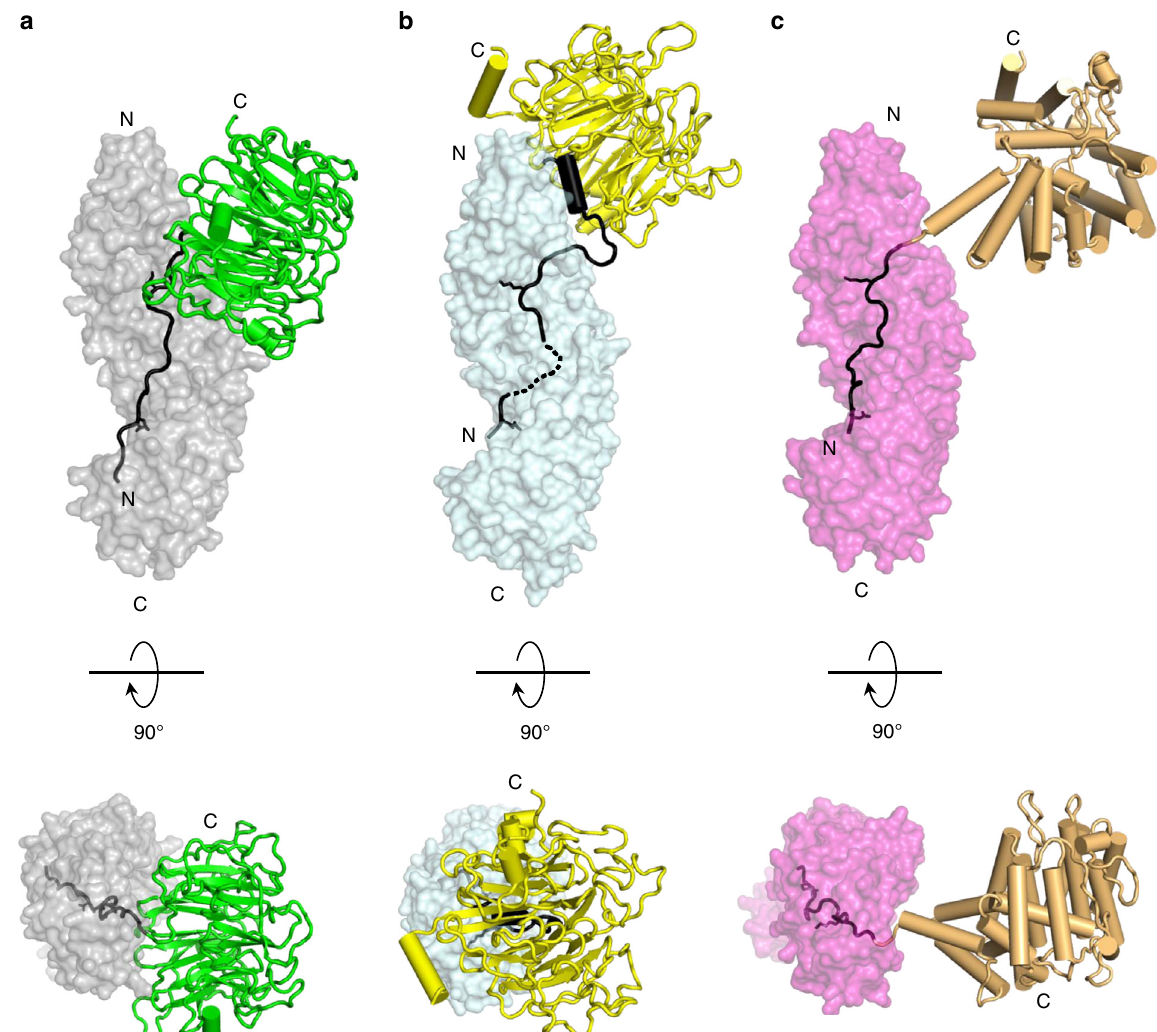
Fig. 8 Differential recognition of NLS cargos by importin α s. Recognition of a human RCC1 ( green ) by importin α 3 ( gray ), b yeast RCC1 ( yellow ) by Kap60 ( light cyan ), c CAP80 ( orange ) by importin α 1 ( magenta ) (PDB ID 3FEY). For clarity, residues 385 – 790 of the CAP80 are not shown. NLSs and fl anking residues that make contacts with importin α s are shown in black; residues at P 2 and P 2 ′ are shown as